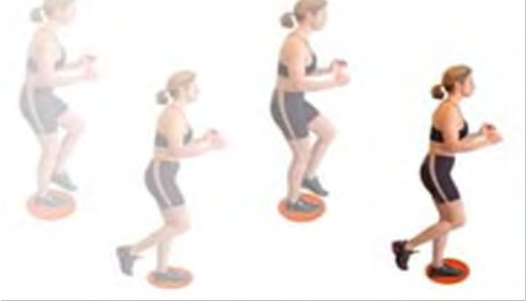
Fig.2. Schema of fulfillment of test-balance